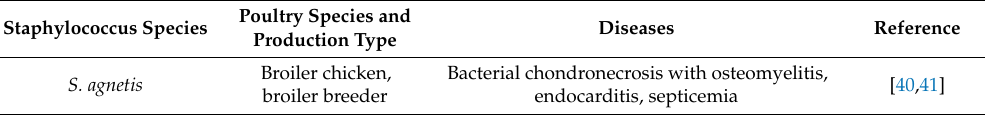
Table 1. List of Staphylococcus species associated with infections in